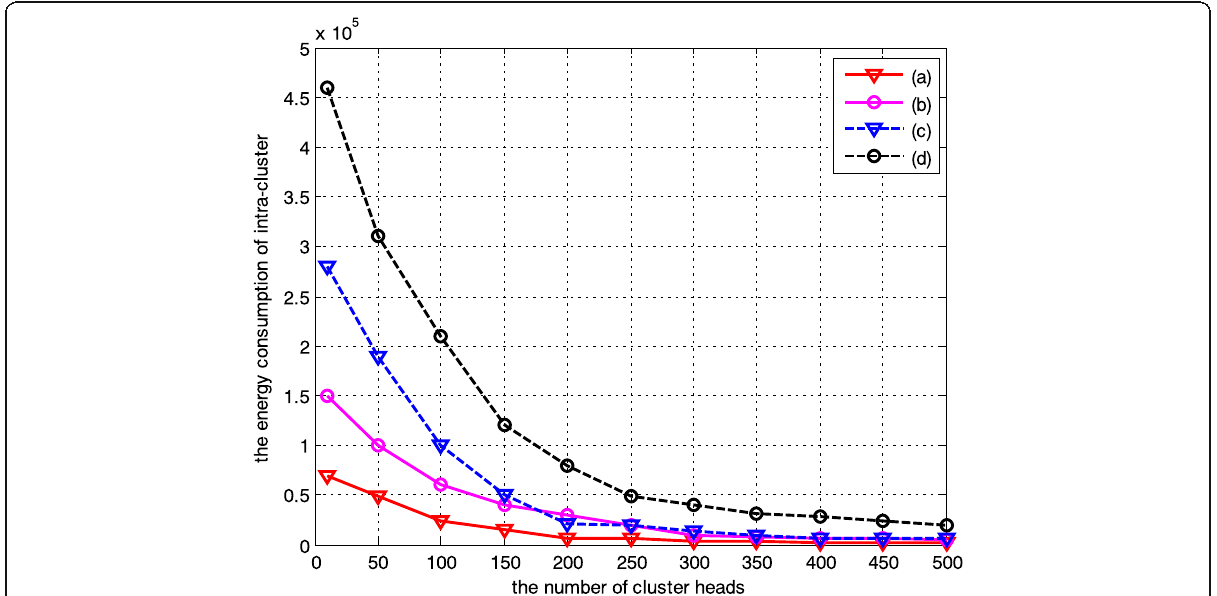
Fig. 9 Comparison of change of the energy consumption of